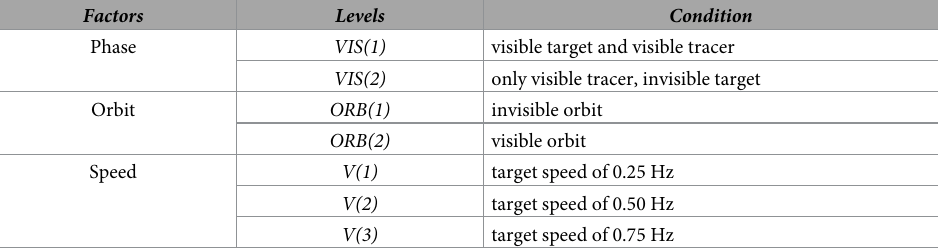
Table 2. Summary of the factors and levels related to the statistical